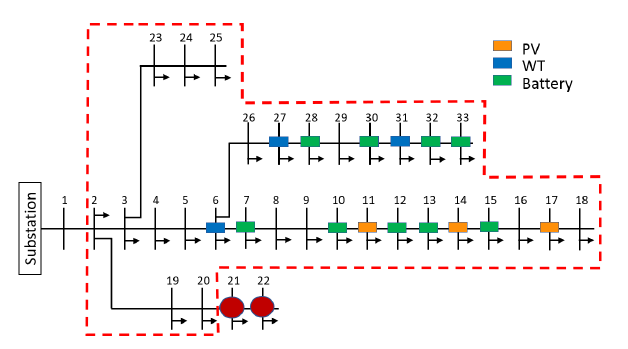
Figure 7. PG&E 33-bus radial DN partitioning for the second scenario at 46 h, considering DSR in the